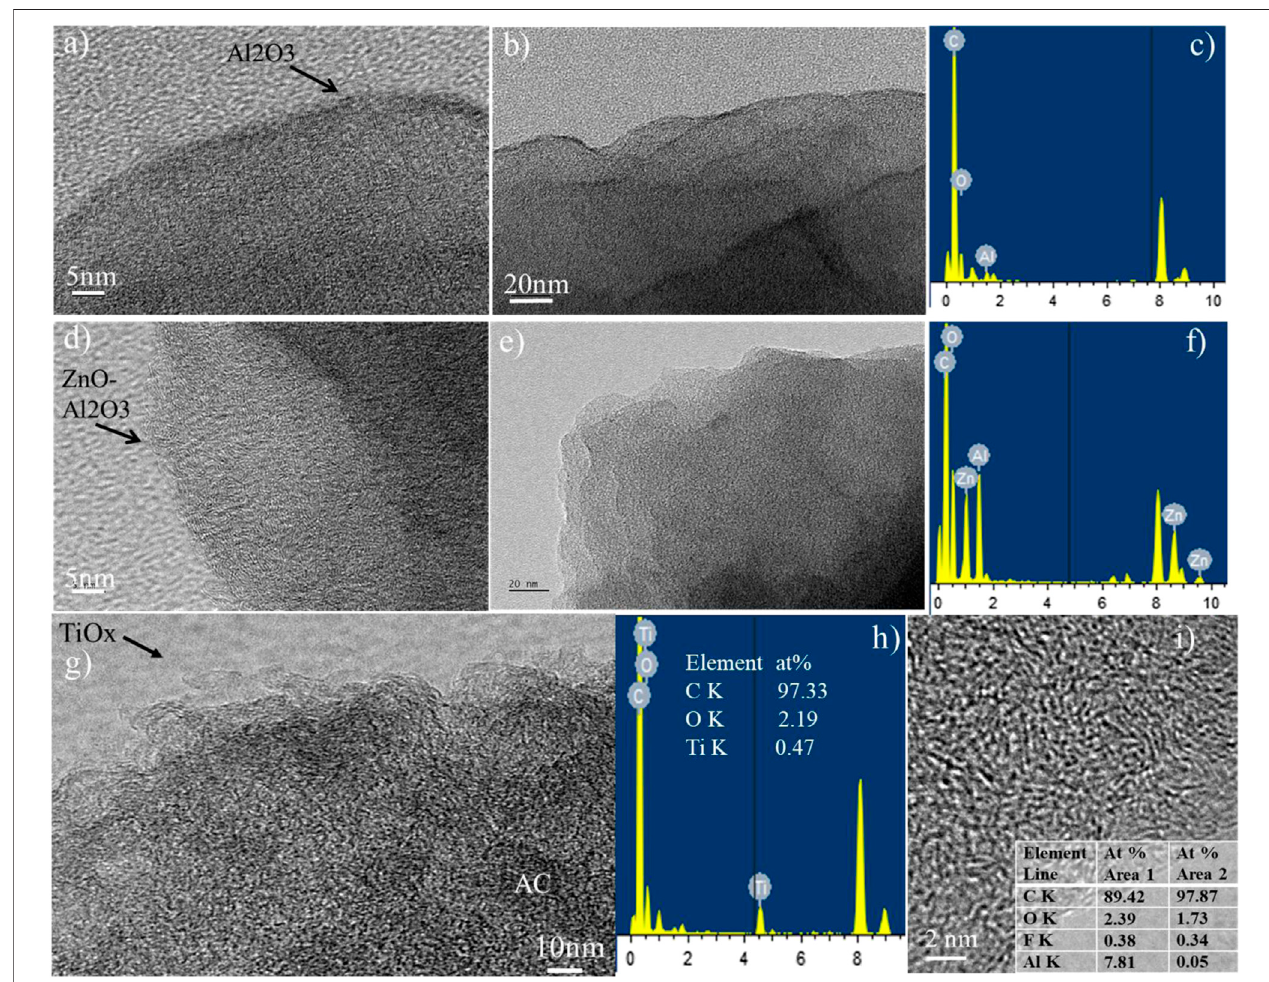
FIGURE4| TEMimagesandEDSofACelectrodescoatedwith20-cycleALDAl 2 O 3 (A – C) ,20-cycleALDZnO-Al 2 O 3 (D – F) ,andTiO 2 − x (G,H) ,TEMimageandEDS elemental concentration (I) .